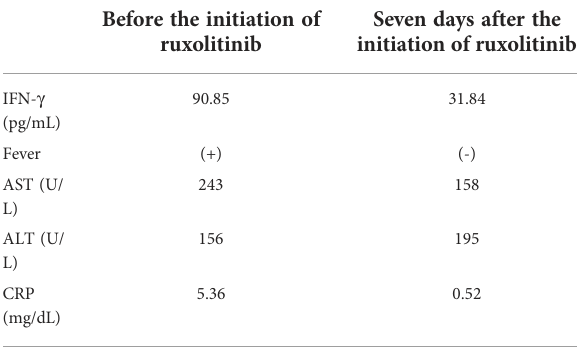
TABLE 2 The effects of ruxolitinib on Case 18.